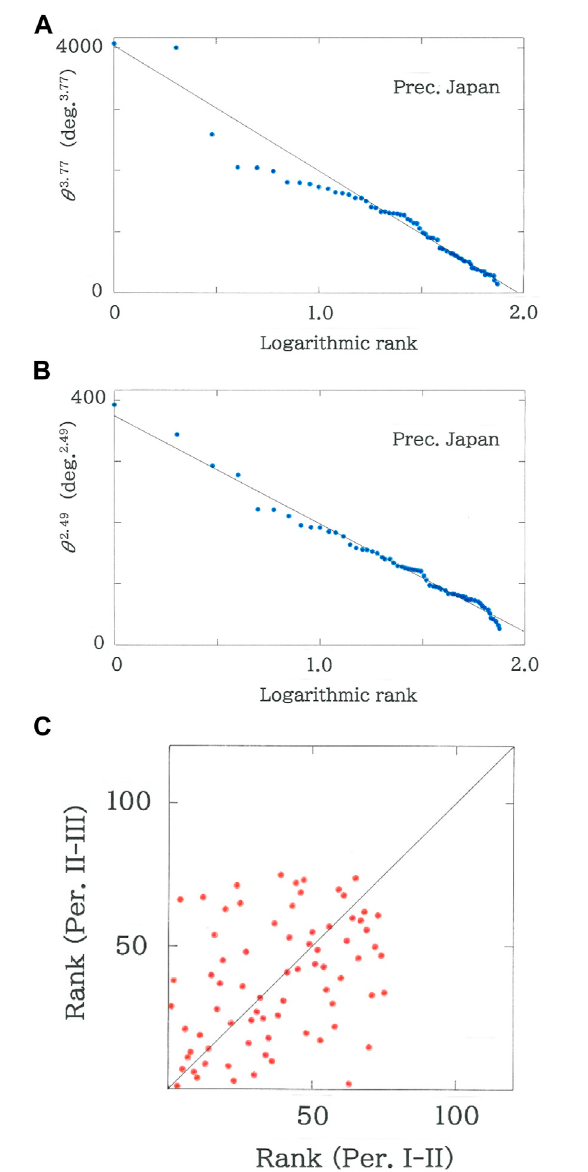
FIGURE 6 | Rank dependence of the cross angles of the monthly precipitationsontheJapanesestations. (A) FromPeriodI(from1931to1960) toPeriodII(from1951to1980).Thelineindicatestheoptimized fi t(| r | (cid:1) 0.9705 with d (cid:1) 0.666 for q (cid:1) 3.77 and n (cid:1) 74). (B) From Period II (from 1951 to 1980)toPeriod III (from1981to2010). Thelineindicates theoptimized fi t(| r | (cid:1) 0.9932with d (cid:1) 0.540for q (cid:1) 2.49and n (cid:1) 75). (C) Scattergramofrankdataof Period II to III versus the data of Period I to II ( r S (cid:1) 0.3797 with d (cid:1) 1.992 for n (cid:1) 75).